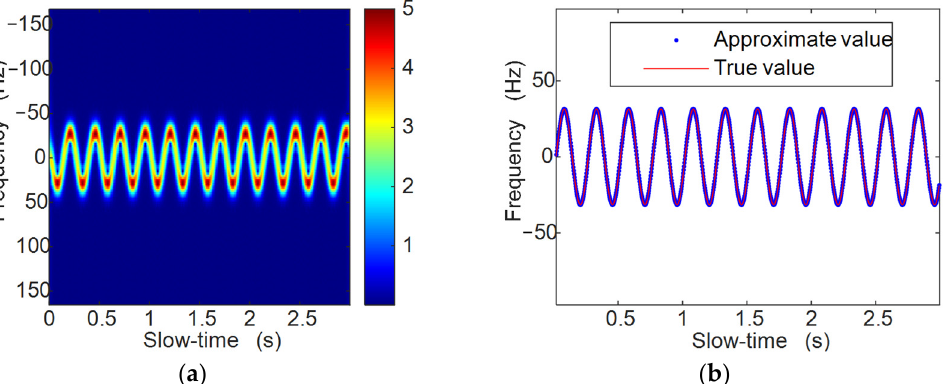
Figure 3. Simulations of the micro-Doppler effect of a scatterer with rotation. ( a ) The echo micro- Doppler frequency curve. ( b ) Theoretical micro-Doppler frequency curve.